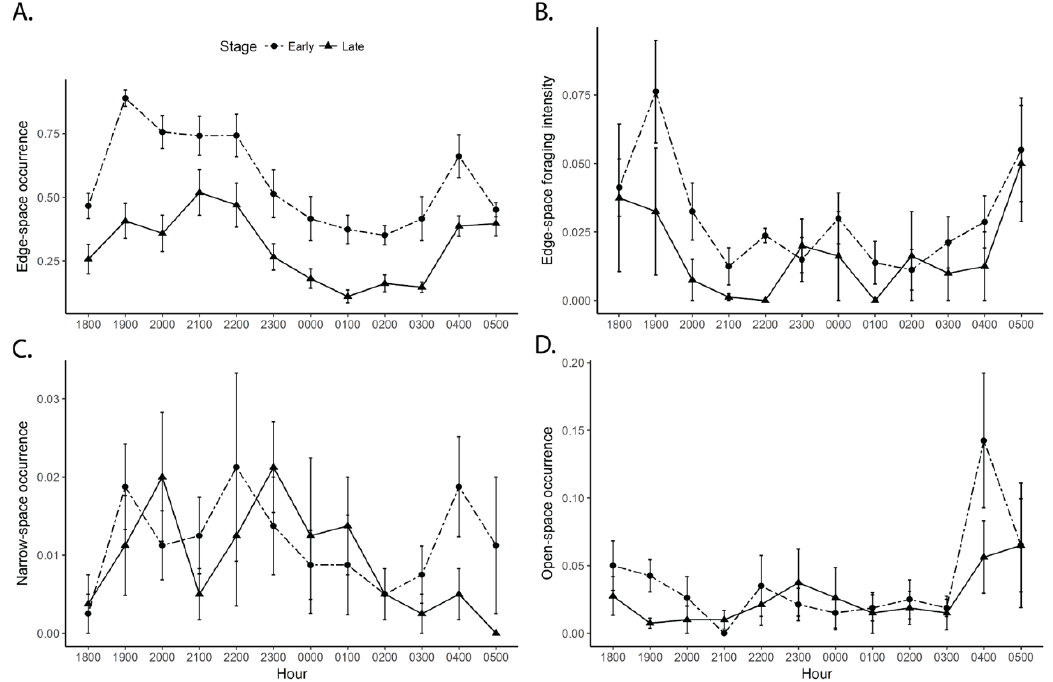
Figure 4. Bat activity by rice growth stage recorded at rice level during the 2016 wet season. Average ( ± standard deviation) edge-space occurrence ( A ) and foraging intensity ( B ), narrow-space occurrence ( C ), and open-space occurrence ( D ) by hour and rice growth stage (Early = dashed line, Late = solid line). Note di ff erences in